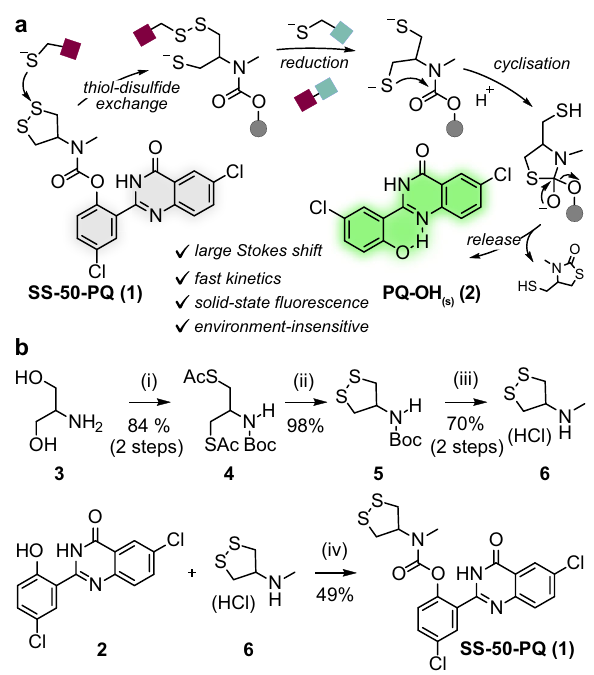
Fig. 2 1,2-dithiolane probe design and synthesis. a After opening or reduction of the 1,2-dithiolane in SS50-PQ , thiolate cyclisation releases the precipitating phenol PQ-OH that gives ESIPT-based fl uorescence in the solid state. b Synthesis of SS50-PQ : (i) Boc 2 O, NEt 3 , dioxane/H 2 O, r.t., 15 h (96%); then either MsCl, py, DCM followed by KSAc, acetone, 60 °C, 2 h (89%), or HSAc, PPh 3 , DIAD, THF, 0 °C to r.t., 15 h (88%). (ii) KOH, MeOH, open to air, r.t., 15 h (98%). (iii) MeI, NaH, DMF, 0 °C to r.t., 0.5 h (70%). (iv) PQ-OH , triphosgene, NEt 3 , DCM, 0 °C to r.t., 1 h; then 6 , NEt 3 , DCM, 0 °C to r.t., 1 h